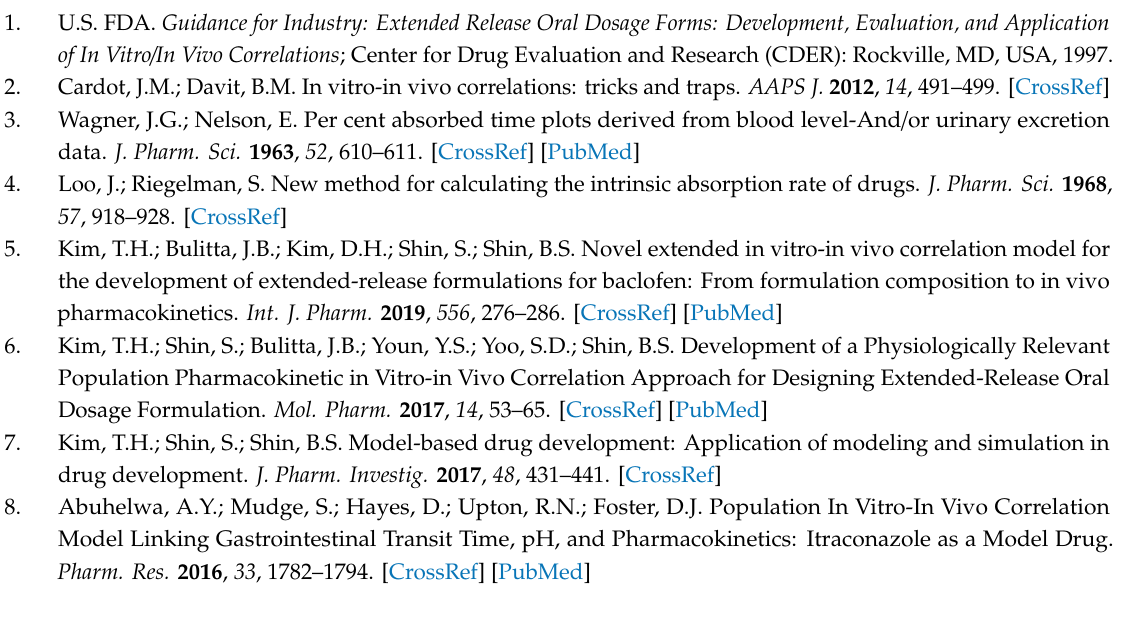
Figure S1: Comparison between the observed and the predicted percentage of drug release profiles of sildenafil IR and SR tablets, Figure S2: Comparison between the observed and fitted plasma concentrations of sildenafil obtained after oral administration of the IR and SR tablets in Beagle